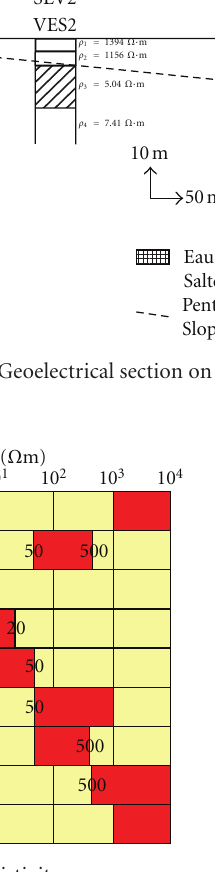
Figure 11: Range of rocks